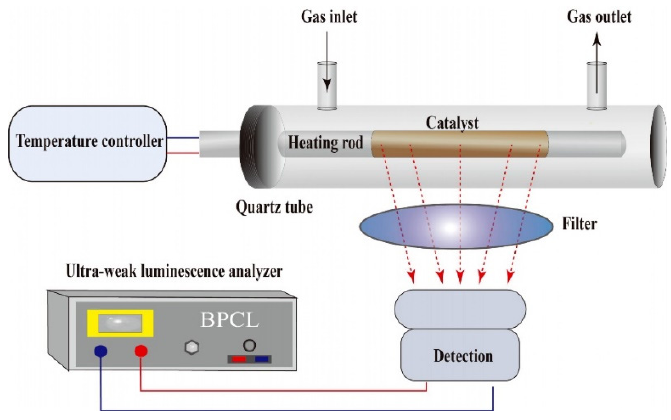
Figure 7. Schematic diagram of the CTL sensor for